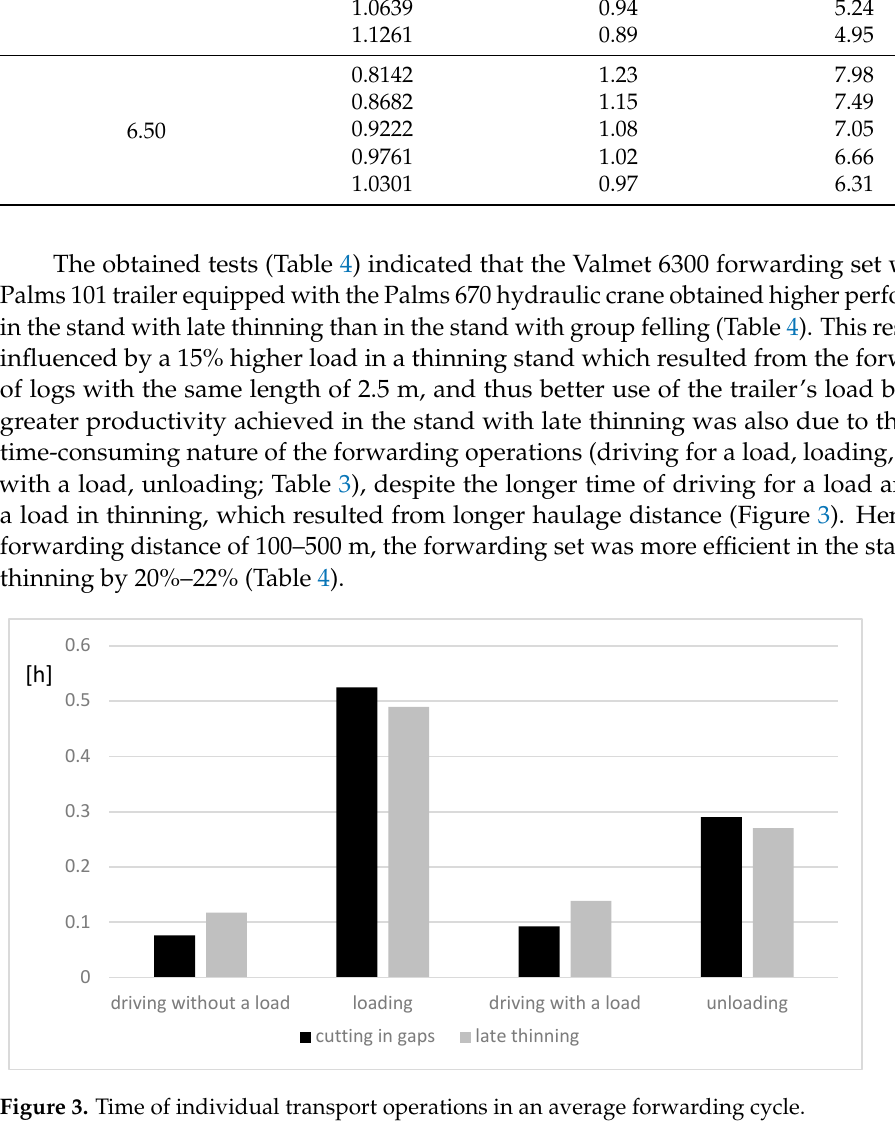
Table 5. Calculation of annual and hourly direct costs of short wood forwarding. Cost Items